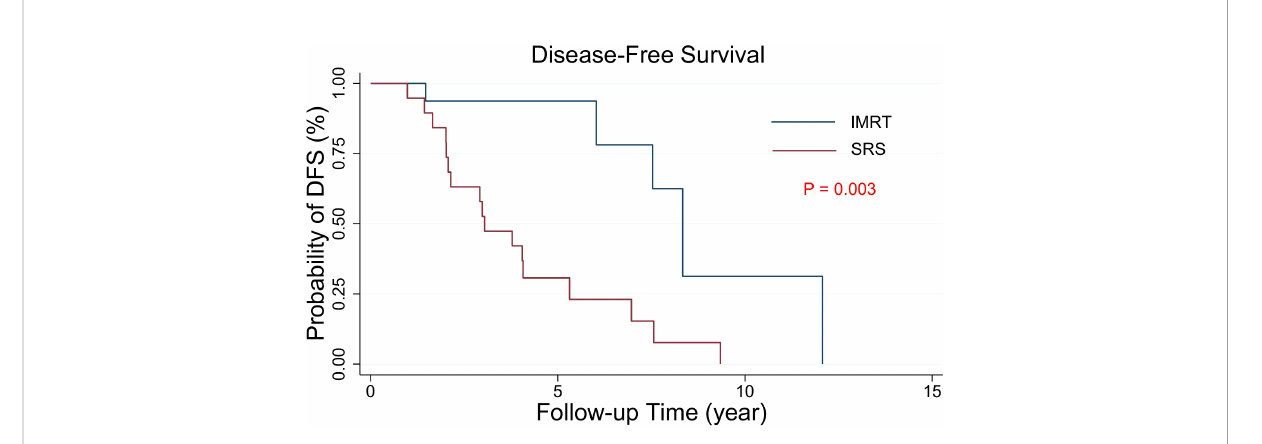
FIGURE 2 Kaplan − Meier estimates of the DFS curves in intracranial SFT/HPC patients with PORT. The DFS of the two groups with different radiotherapy techniques was signi fi cantly different (p =